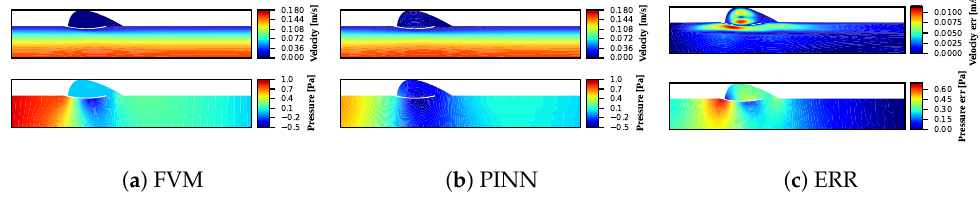
Figure A3. Laminar flow: 75 degree